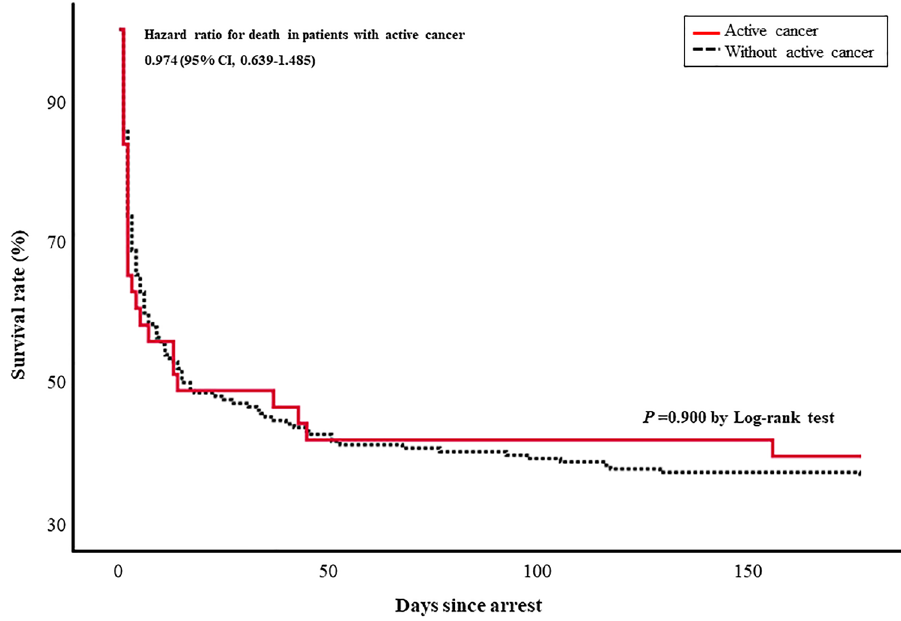
Figure 3. Kaplan–Meier survival curves over 6 months in patients with and without active cancer.